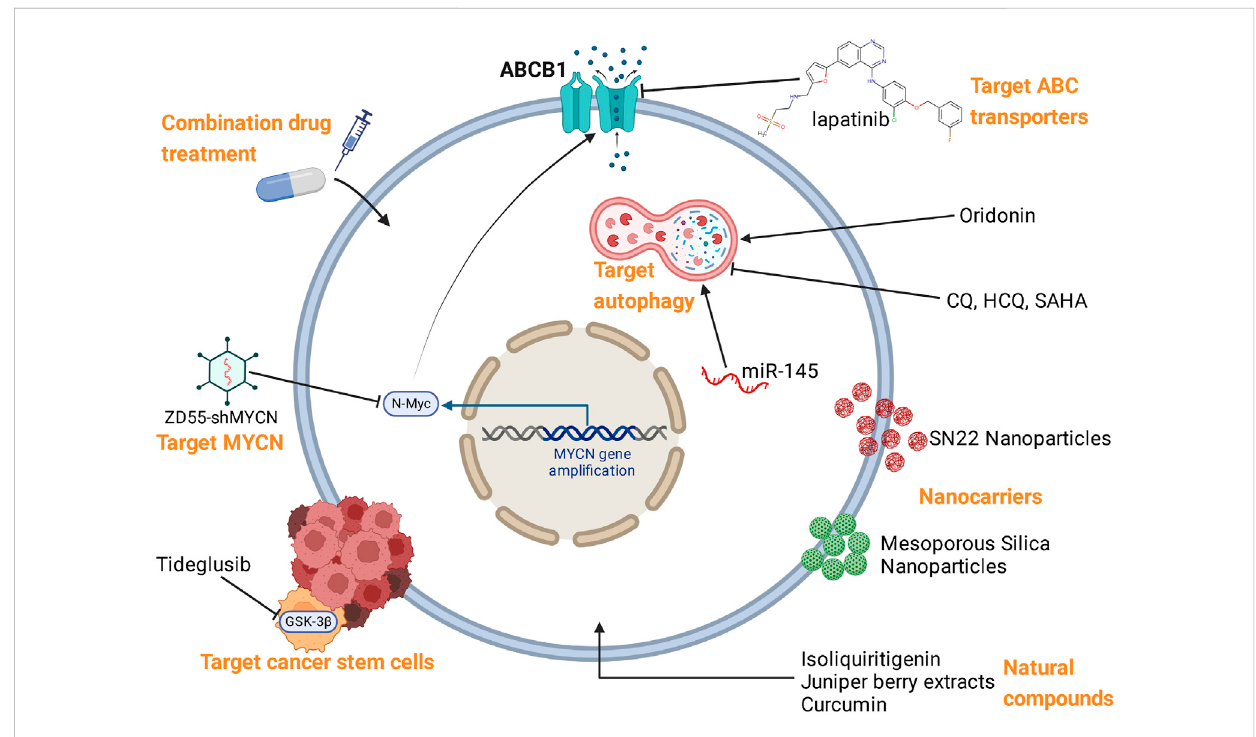
FIGURE 3 Reversal strategies for therapy resistance of